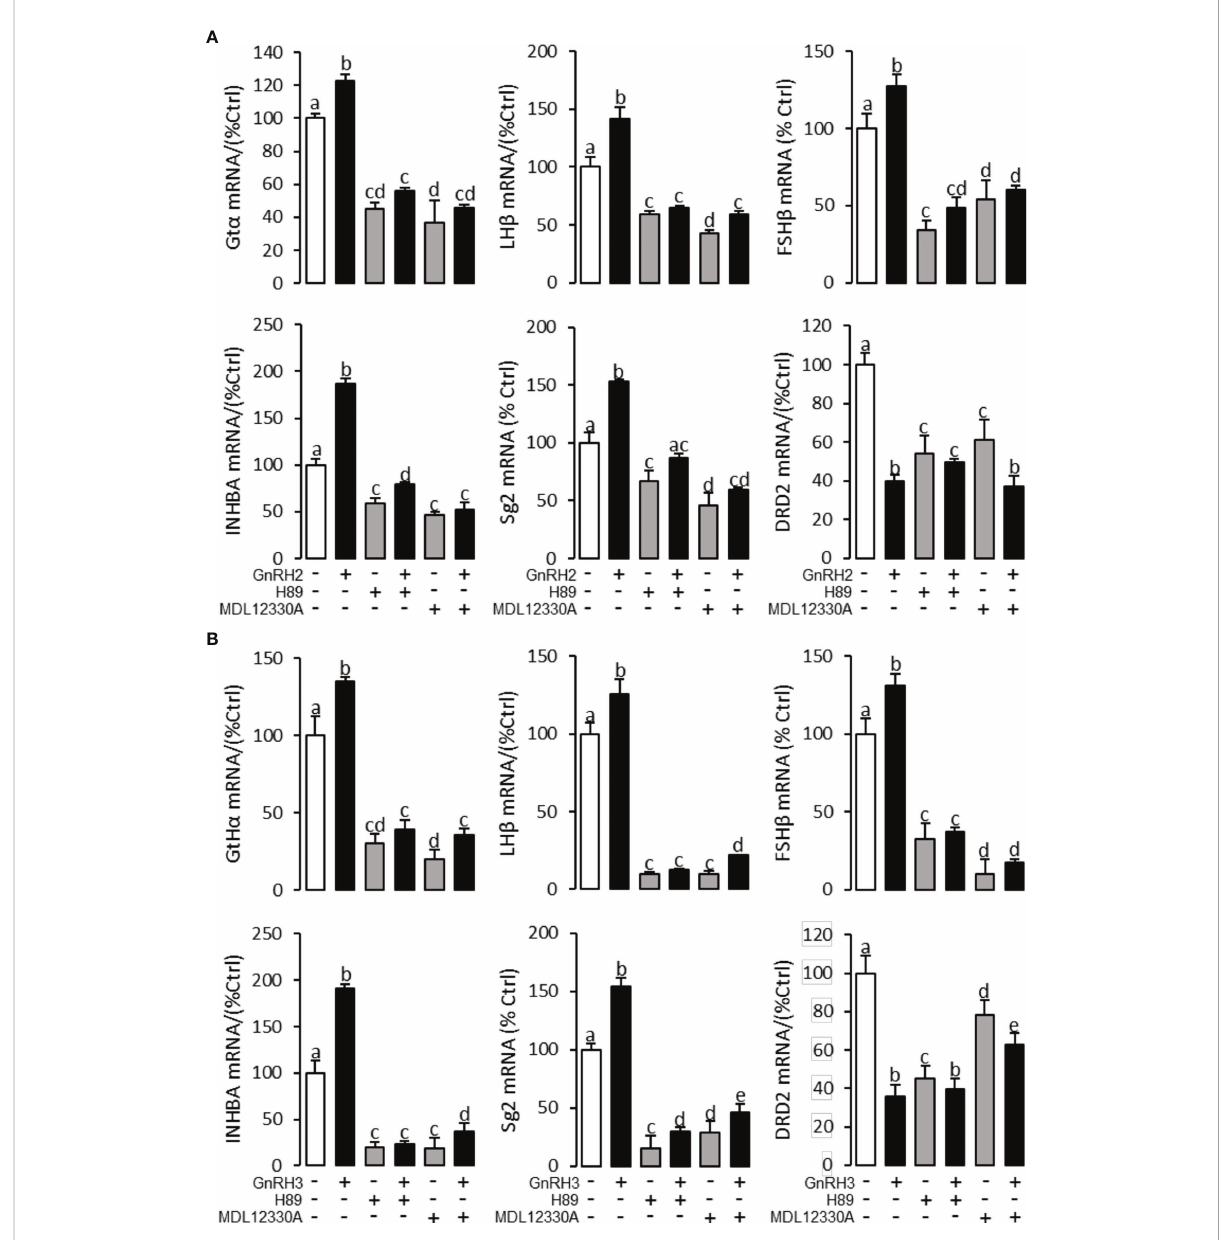
FIGURE 7 Signal transduction for GnRH2- and GnRH3-regulated GtH a , LH b , FSH b , INHBa, SgII, and DRD2 mRNA expression in grass carp pituitary cells. In this experiment, GnRH2 (A) or GnRH3 (B) combined with / without the AC inhibitor MDL12330A (20 m M) or PKA inhibitor H89 (20 m M) was used to incubate the grass carp pituitary cells for 24 (h) After drug treatment, the total RNA was extracted from the cells for real-time PCR of the respective genes. Data presented are expressed as mean ± SEM, and the different letters represent a signi fi cant difference at p < 0.05 between groups (ANOVA followed by a Dunnett